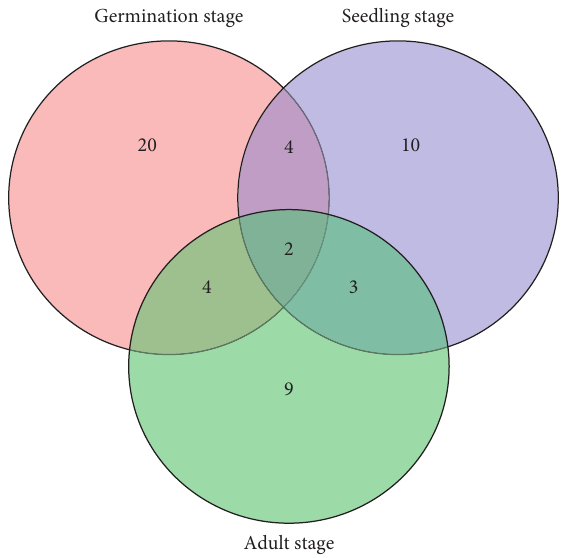
Figure 1: Venn diagrams showing specific and common tolerant germplasm accessions in the three growth